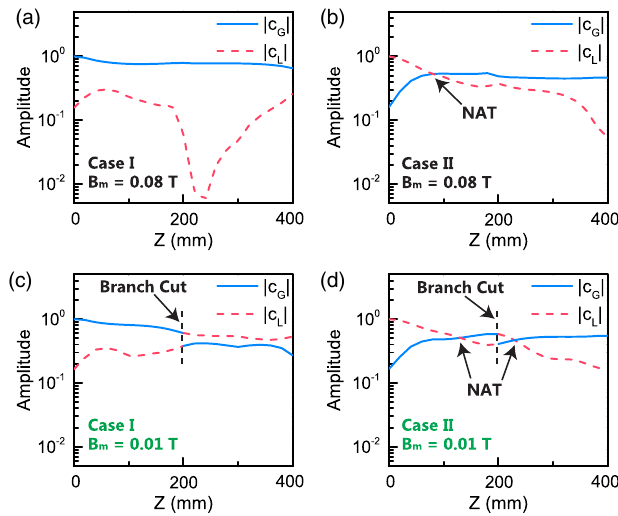
FIG. 4. Calculated amplitudes of the eigenstates along the ¼ 0 . 08 T, (b) case II waveguiding direction for (a) case I with B m ¼ 0 . 08 T, (c) case I with B ¼ 0 . 01 T, and (d) case II with B m m ¼ 0 . 01 T, where c with B and c represent the coefficient of m G L the eigenstate projected onto the lower-loss and higher-loss Riemann sheets, respectively. The black dashed lines in (c) and (d) show the existence of a branch cut via which the state can cross from one Riemann sheet to the other. The NAT is characterized by the crossing of two